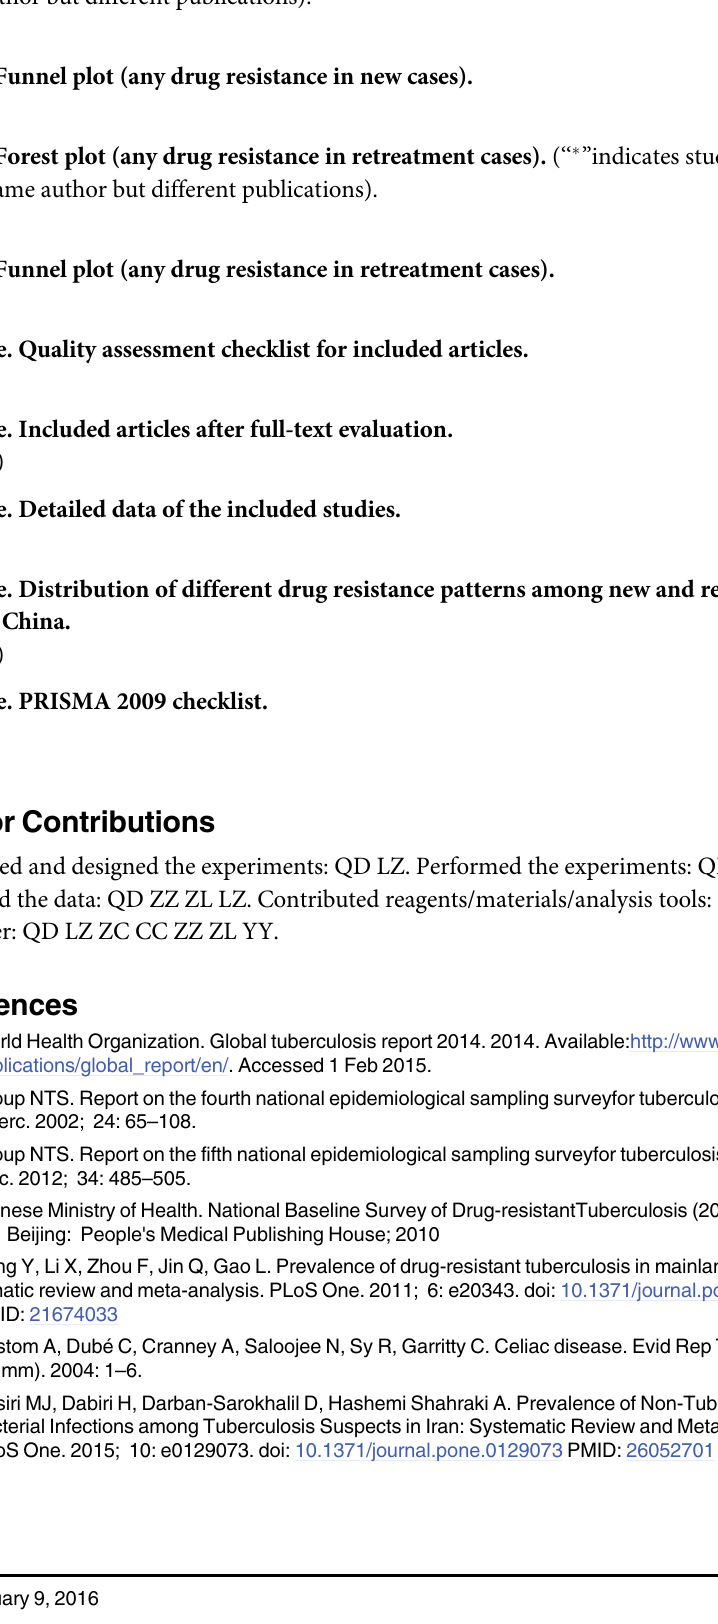
S3 Fig. Forest plot (any drug resistance in retreatment cases). ( ‘‘ (cid:1) ” indicates studies reported by the same author but different publications).